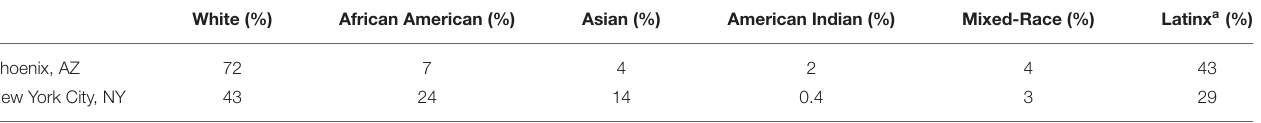
TABLE 2 | Demographics of Phoenix, AZ and New York City, NY. White (%) African American (%) Asian (%) American Indian (%) Mixed-Race (%) Latinx a (%) Phoenix, AZ 72 7 4